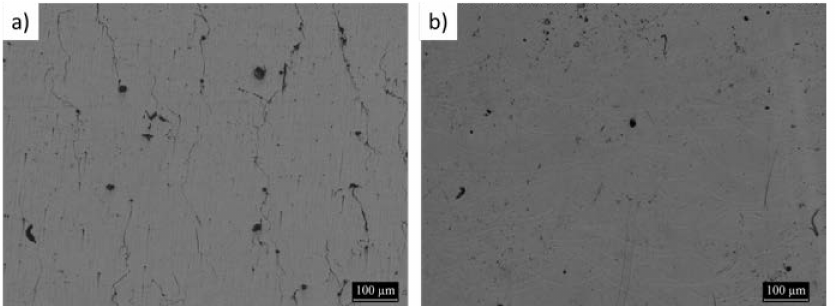
Figure 2. Optical micrographs of ( a ) 7075 alloy and ( b ) 50% 7075 alloy built with not optimized process parameters ( P = 195 W, v = 600 mm/s and h d = 0.17 mm).